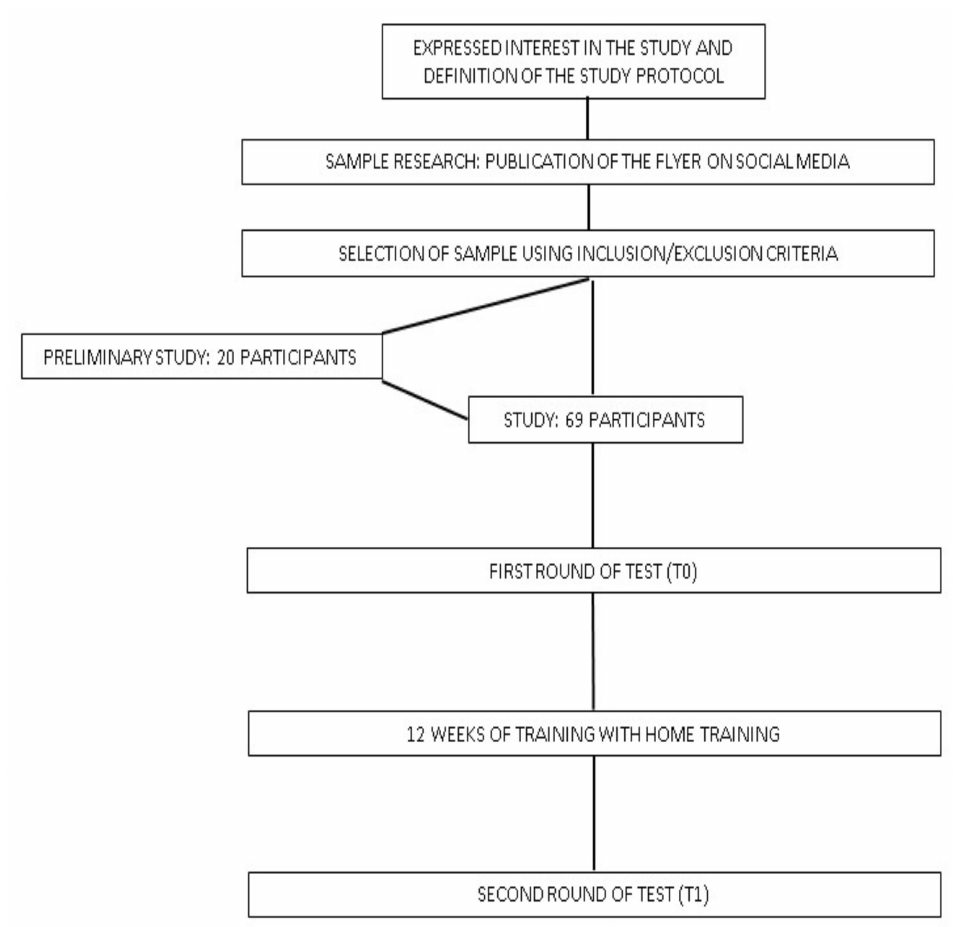
Figure 9. Flowchart of the